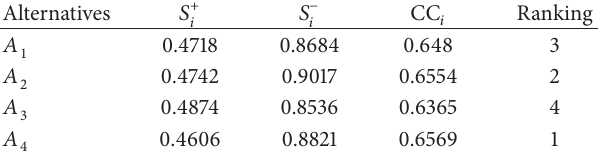
Table 4: Closeness coefficients of alternatives along with the final ranking.